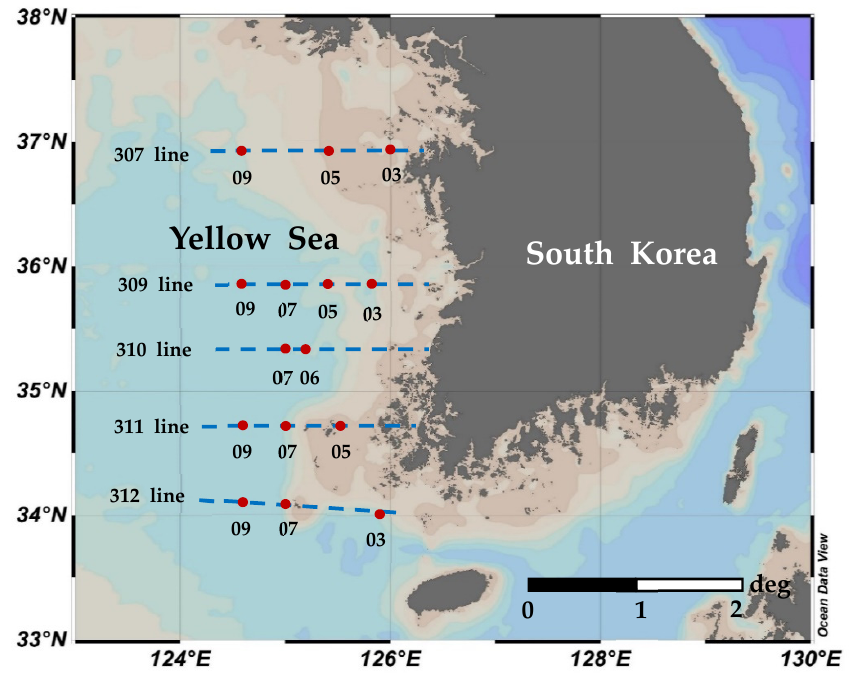
Figure 1. Sampling locations in the YS, 2019. The blue dotted lines are managed by the serial oceanographic observation project of the National Institute of Fisheries Science (NIFS) in Korea.